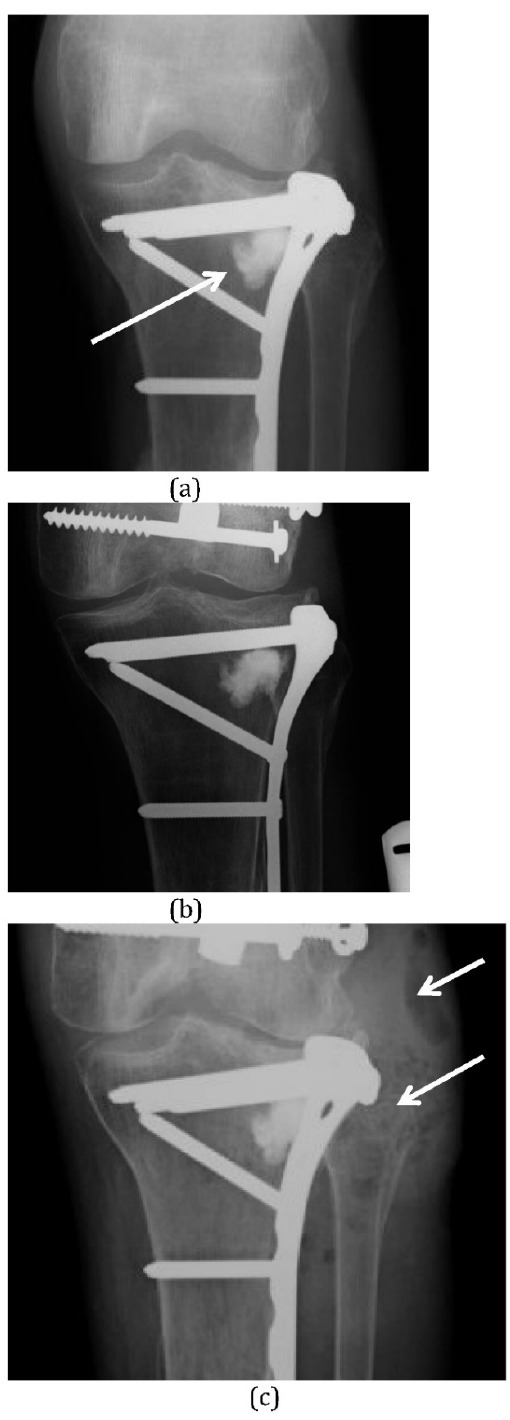
Figure 2. (A) This proximal tibial plateau fracture was treated with open reduction and internal fixation. Elevation of the depressed plateau created a bone void in the lateral condyle which was filled with a composite of -tricalcium phosphate, calcium carbonate and monocalcium phosphate (Norian™) (white arrow). (B) Radiograph taken 4 years later shows no α remodelling of this very stable ceramic. (C) The patient presented again at 6.5 years after implantation of the ceramic with an abscess over the lateral tibia (white arrows) and septic arthritis of the knee. The ceramic material remains unchanged and is now involved in the infection. It was difficult to remove at